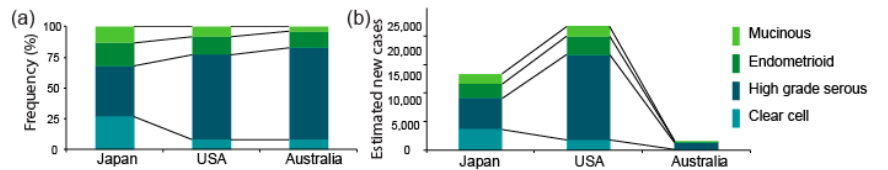
Figure 1. Proportions of OCCC and estimated numbers of new OCCC cases per year. ( a ) Proportions of OCCC among all epithelial ovarian cancers in Japan, the US, and Australia, using data obtained respectively from the Cancer Information Service, “Projected cancer incidence in 2020” Available online: https://ganjoho.jp/reg_stat/statistics/stat/short_pred.html (accessed on 19 November 2020);